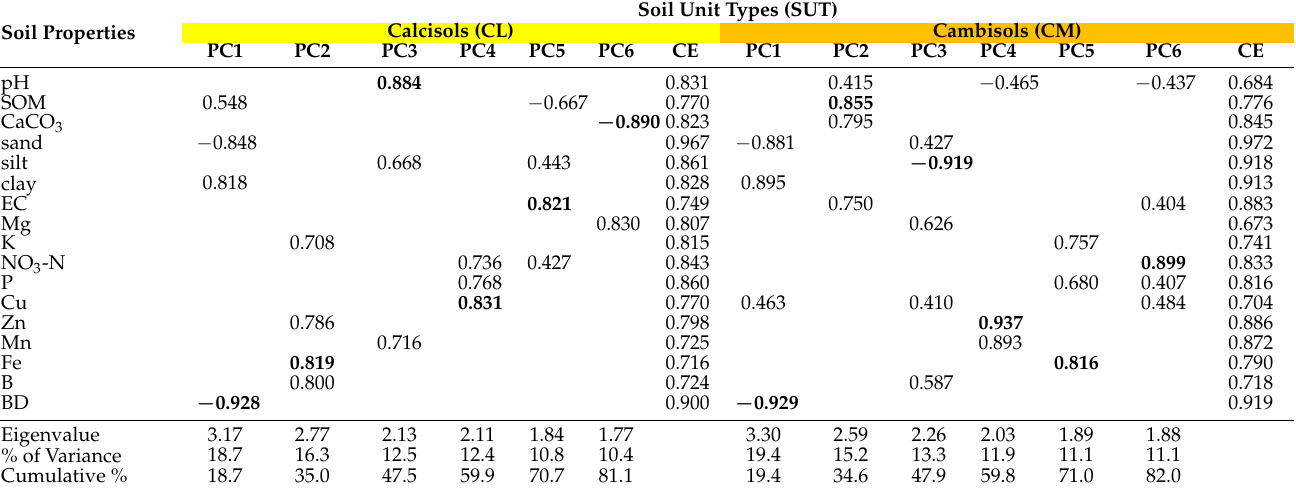
Table 8. Results of the principal component (PC) analysis of soil properties for different soil units